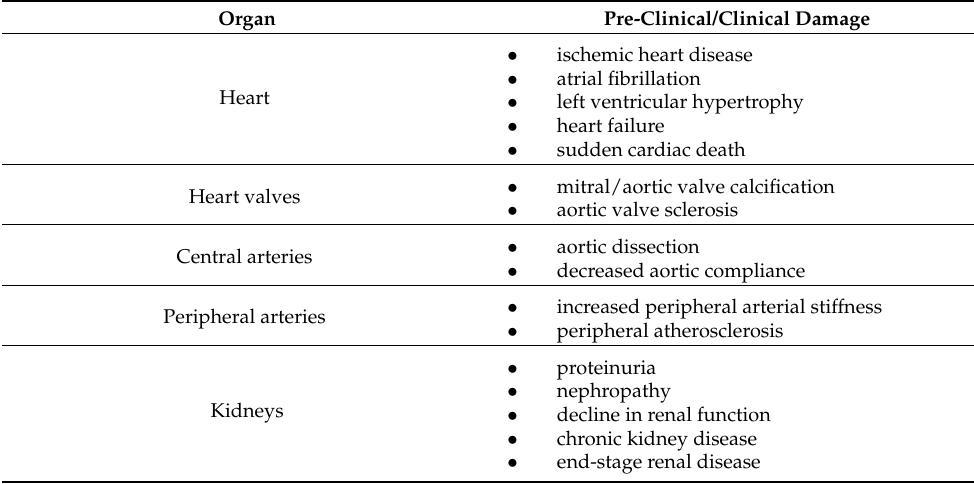
Table 3. Hypertension-related target organ damage